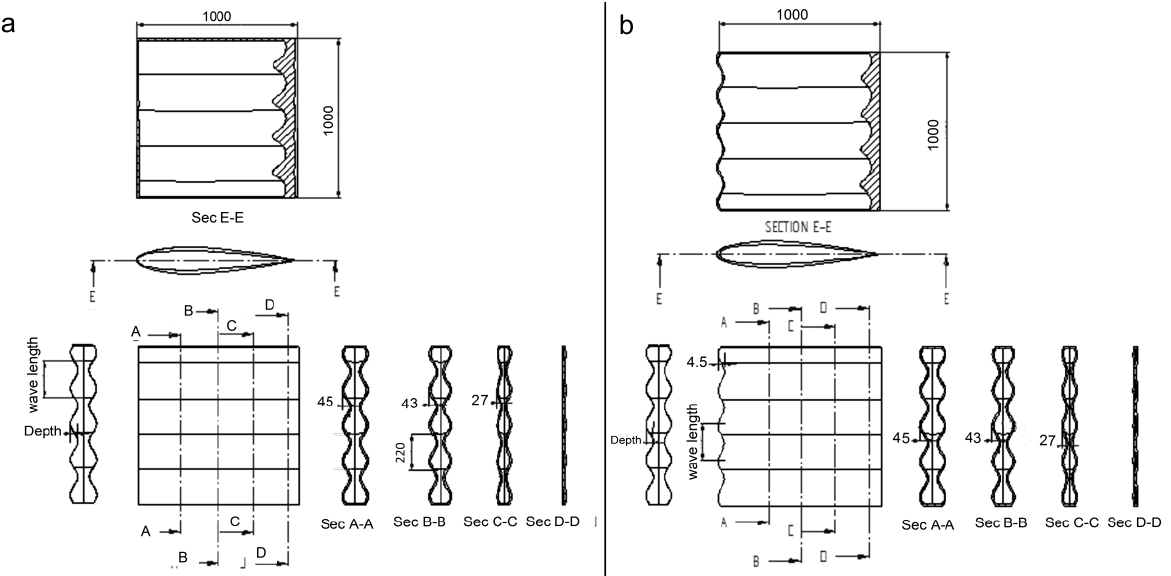
Figure 2. The detail design and the main dimensions of the sinusoidal corrugated profile. ( a ) Linear leading edges, ( b ) sinusoidal corrugated